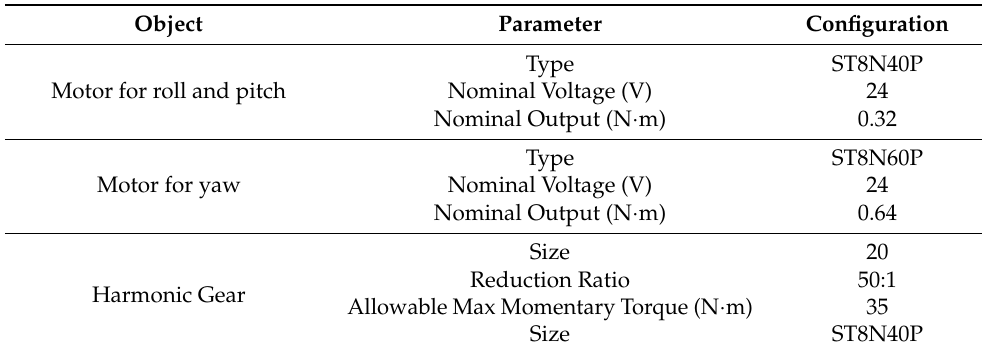
Table 3. Specifications of the motor and